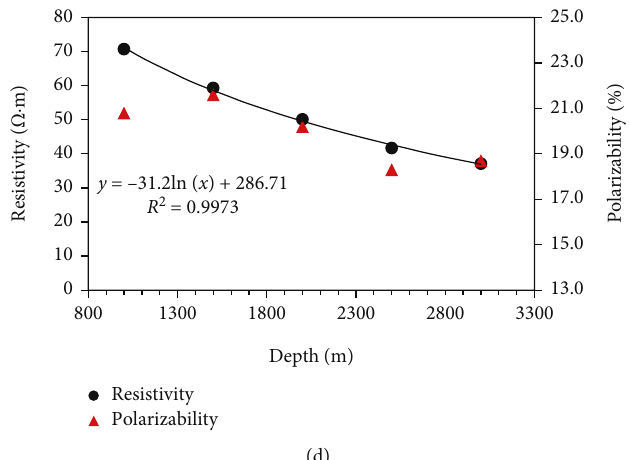
Figure 11: (a – d) The inversion results of the complex resistivity of samples 1, 2, 3, and 5 for di ff erent simulated depths,